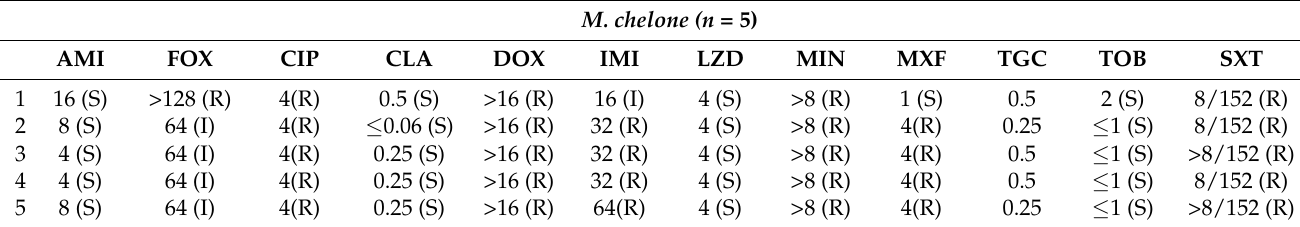
Table 7. Results of in vitro susceptibility testing for M. chelonae strains.